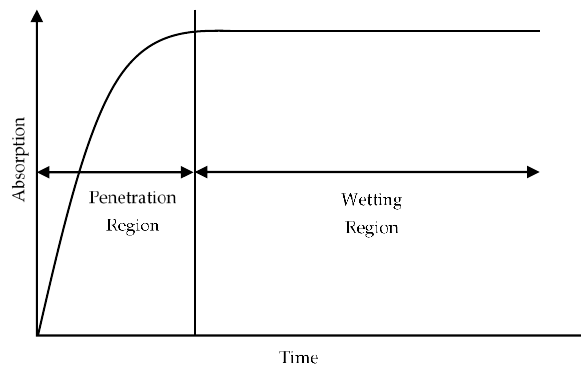
Figure 1. Wetting characteristics of a typical cellulose insulation paper.